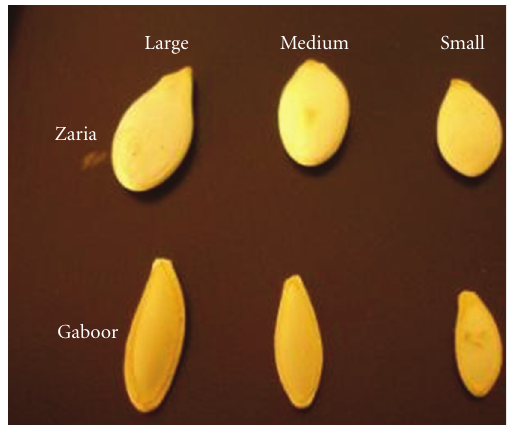
Figure 1: The size categories of two Iranian varieties of pumpkin seed.